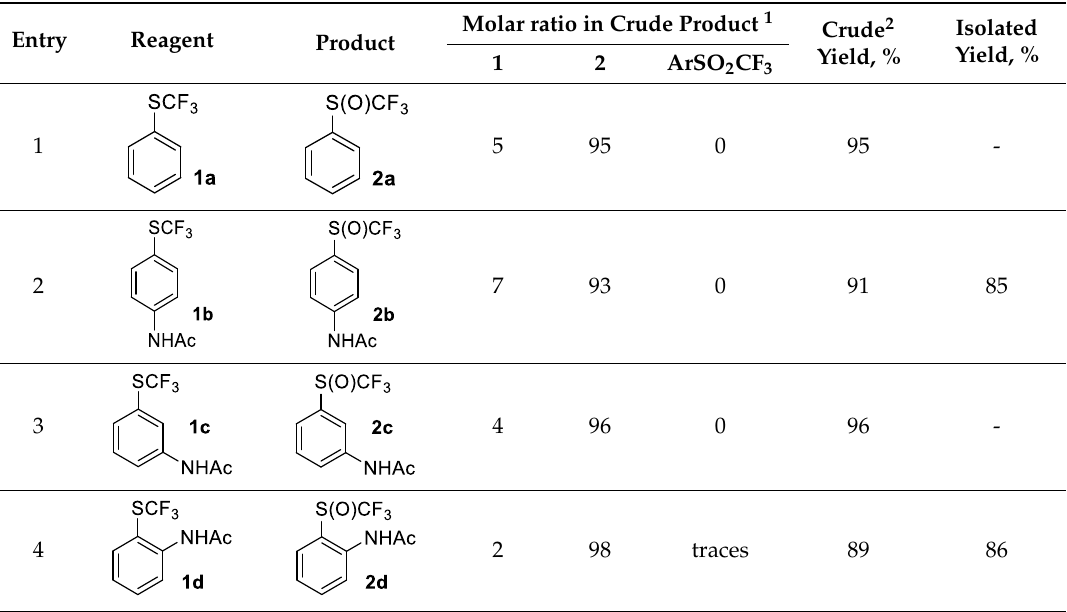
Table 1. Oxidation of aryl trifluoromethyl sulfides 1 .